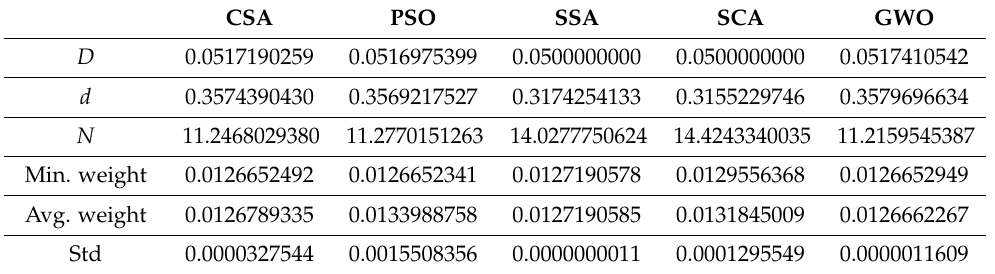
Table 14. Optimal design of tension coil